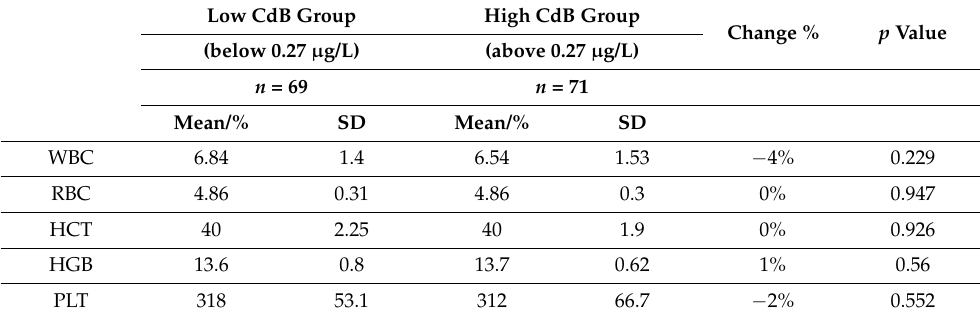
Table 3. Blood count parameters divided into subgroups depending on cadmium concentra- tions in the blood: Low CdB (CdB level below median) and High CdB (CdB value above me- dian). WBC—white blood cells; RBC—red blood cells; HGB—hemoglobin; HCT—hematocrit; PLT—platelets.